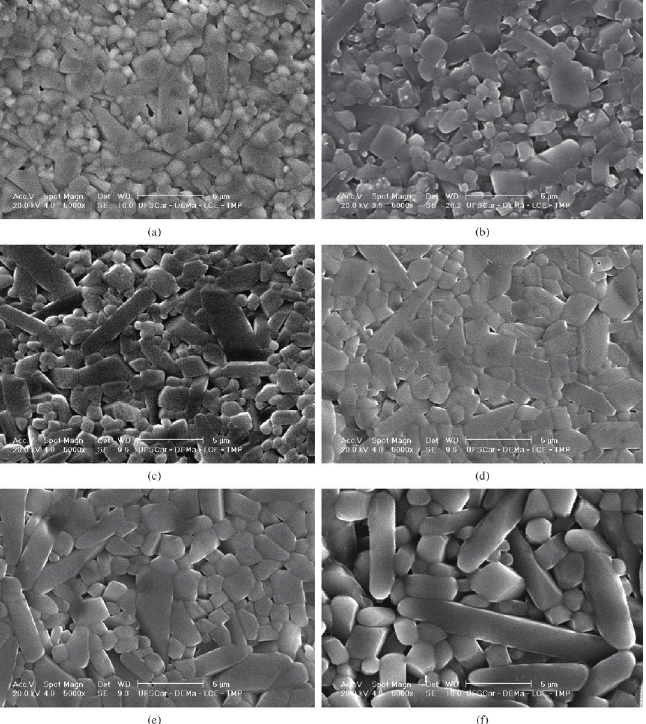
Figure 6. SEM micrographs of MgO doped samples conventionally sintered at 1500 °C/2h: (a) 0.5M, (b) 1M, (c) 2M; and at 1600 °C/2h (d) 0.5M, (e) 1M, (f) 2M.